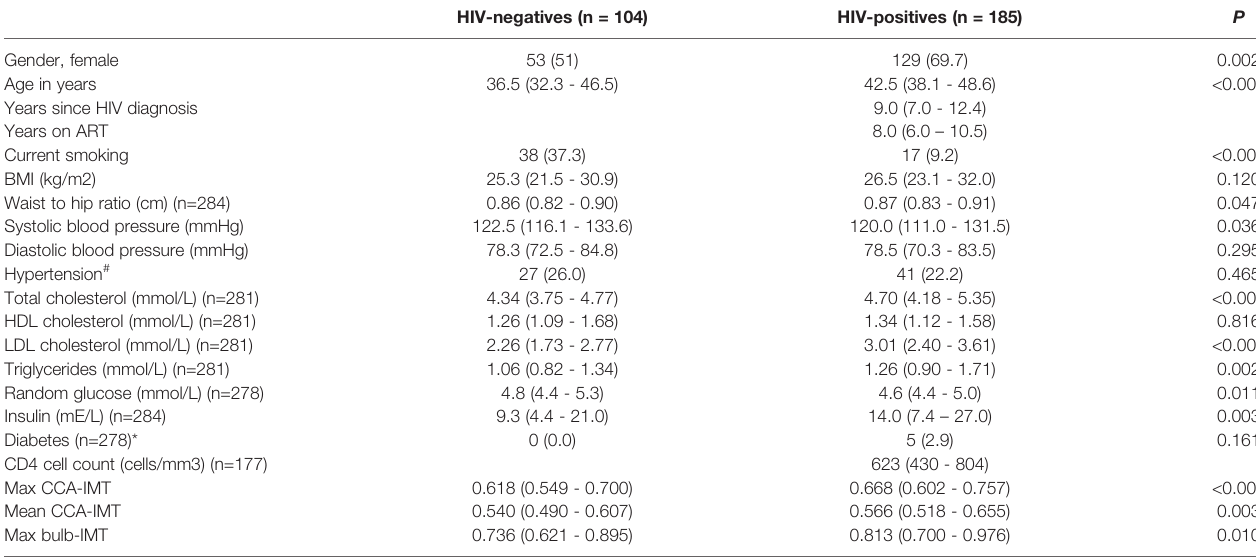
TABLE 1 | Participant characteristics.